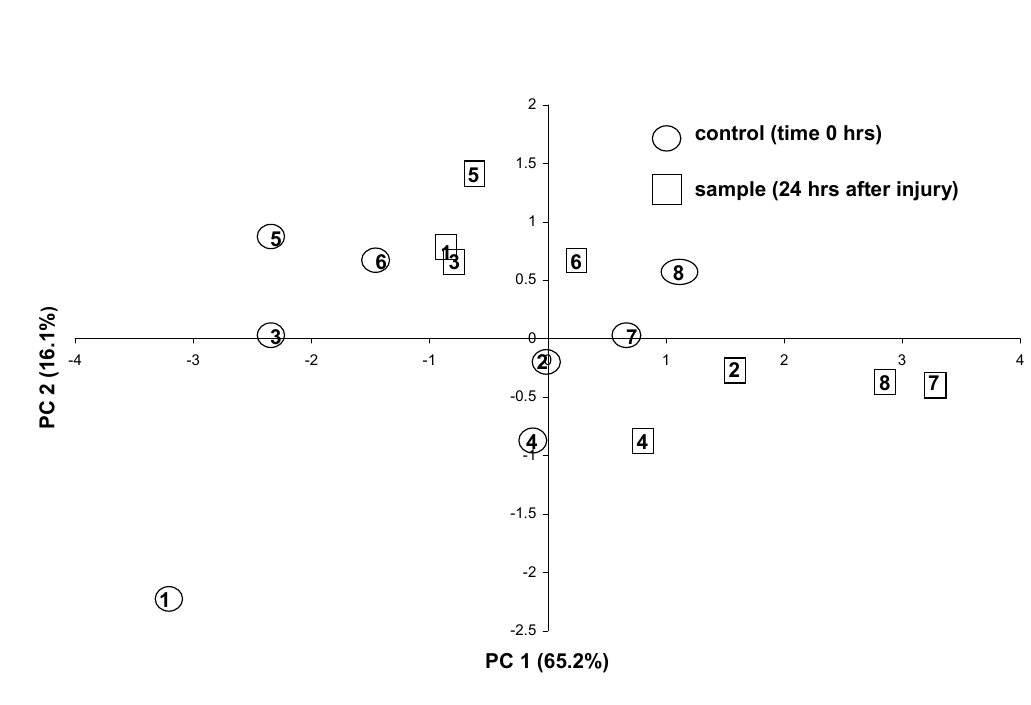
Figure 2. PCA scatterplot of oil-profiles from O. minimum leaves on the first 2 principal components extracted using the group of five compounds as variables (unwounded (T (T ) leaves in squares). Identical numbers indicate same leaf (before – after wounding). Individuals 5- 24 8 were sampled one month after individuals 1-4 to test the reproducibility of the